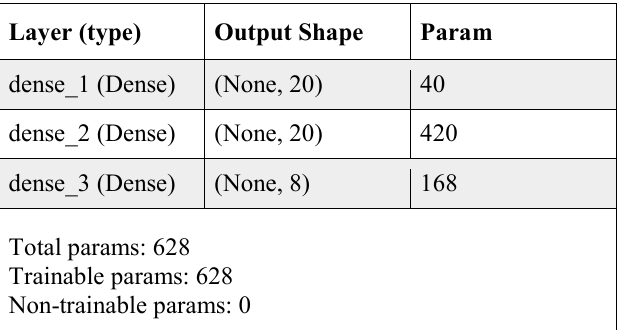
Table 2. Confusion matrix for testing